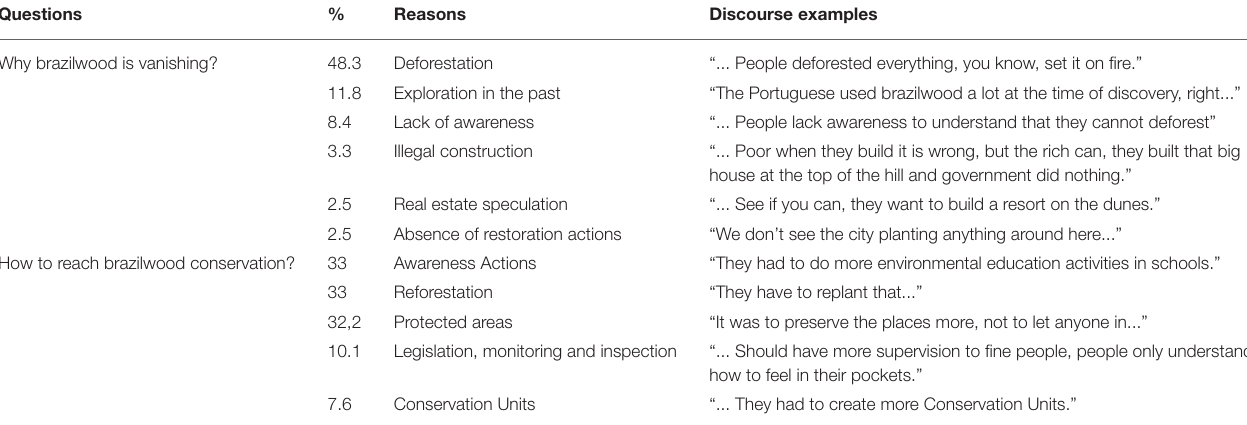
TABLE 4 | Content analysis technique results among the interviewees in the municipalities of Cabo Frio (Peró and Jacaré) and Armação dos Búzios (José Gonçalves) in the state of Rio de Janeiro, Brazil.